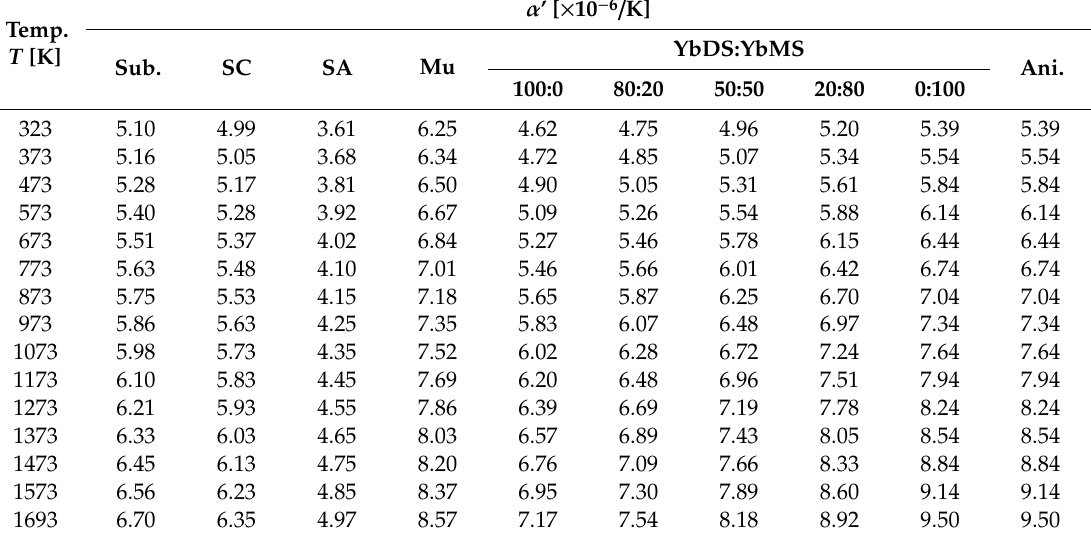
Table 7. Coe ffi cients of thermal expansion (CTEs) at reference temperature of 1673 K ( α ’) of substrate and coating